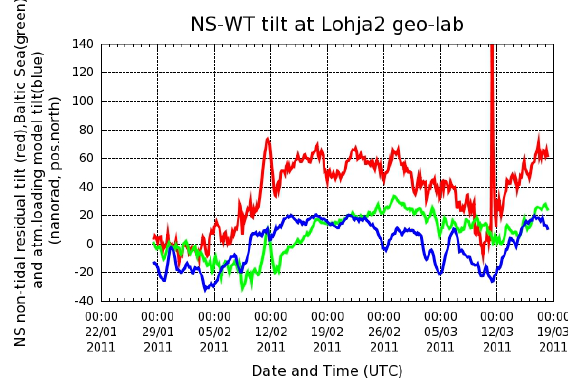
Figure 4: The Baltic Sea loading model tilt (green) and atmospheric loading (blue) and NSWT non-tidal residual (red) at Lohja2